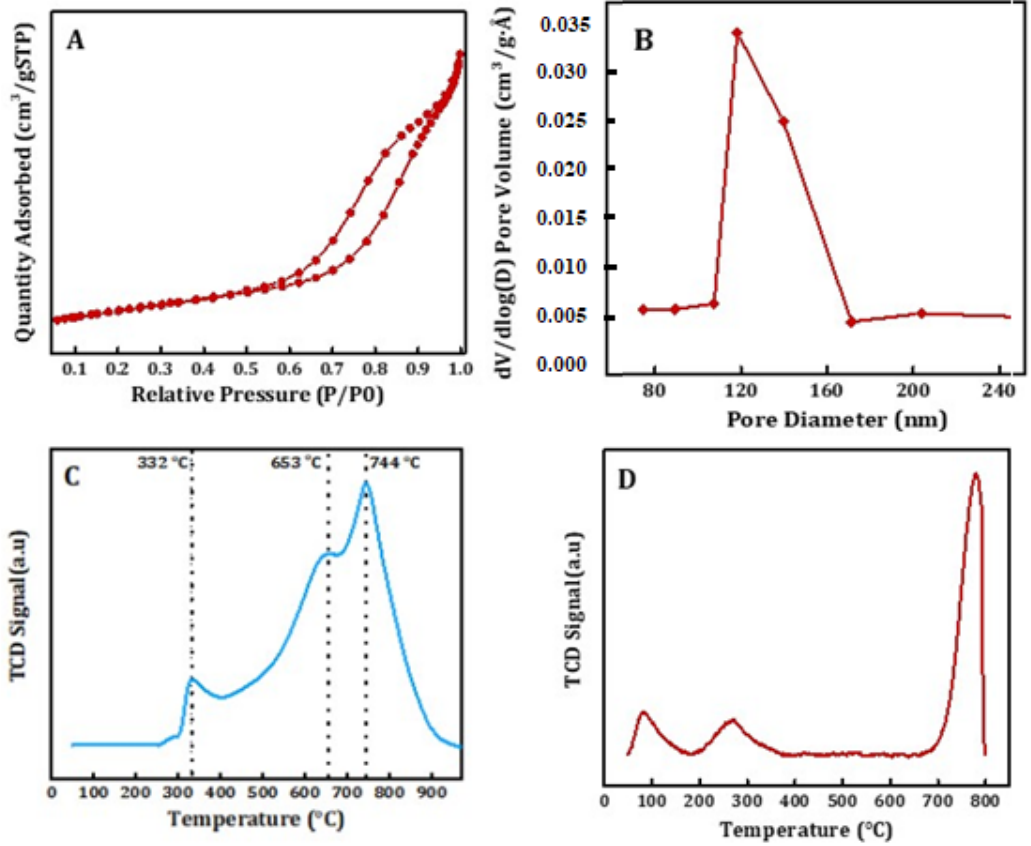
Figure 1. ( A ) N 2 adsorption–desorption isotherms, ( B ) pore size distribution, ( C ) TPR, and ( D ) CO 2 -TPD profile for fresh catalyst calcined at 725 °C.